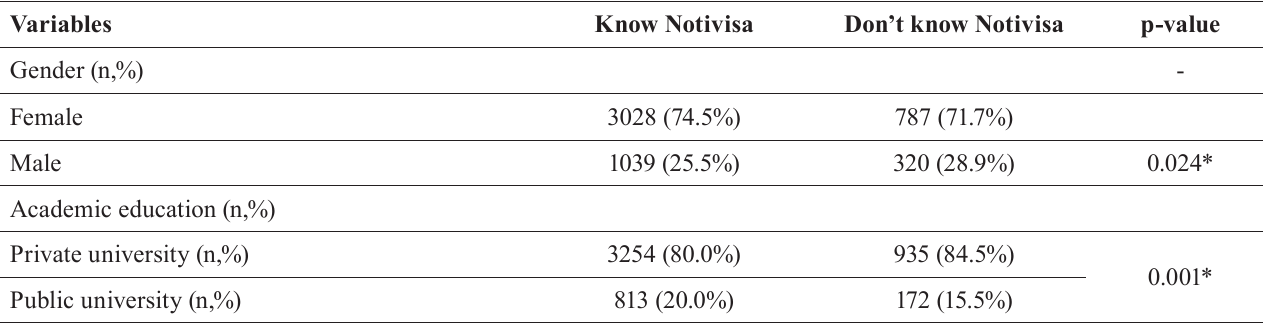
TABLE III - Association between Notivisa’s knowledge and sociodemographic variables Variables